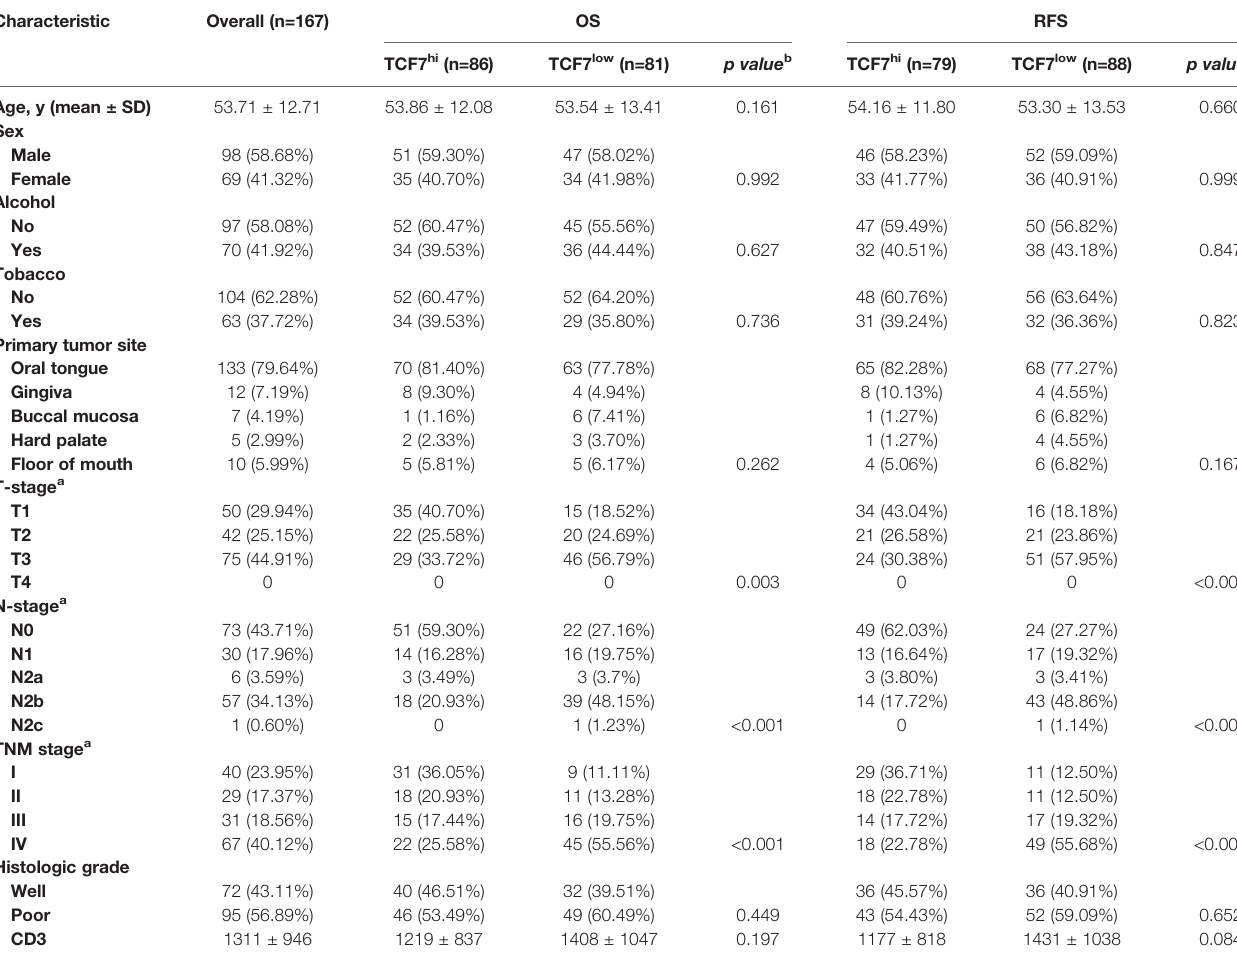
TABLE 1 | Clinicopathological characteristics of OSCC patients according to TCF7 expression.